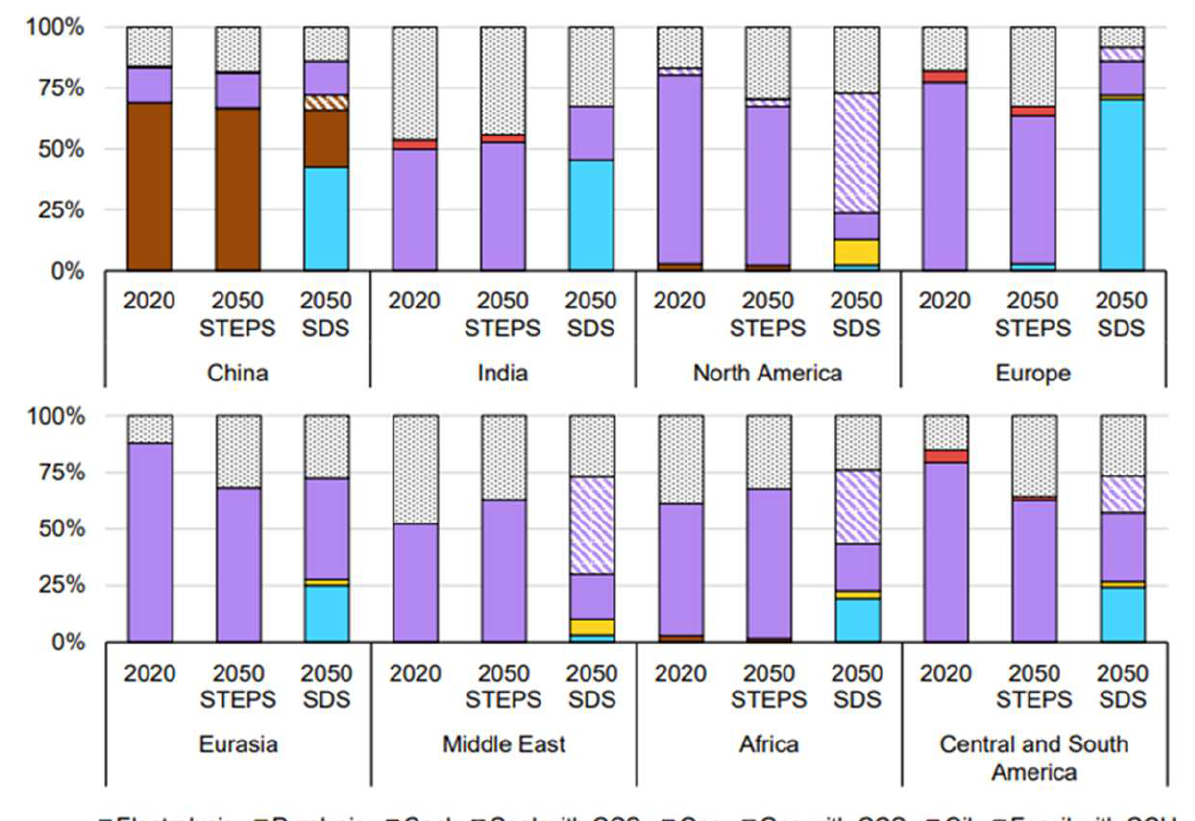
Figure 5. Various ammonia production pathways and scenarios in major ammonia-producing re- gions (STEPS: Stated Policies Scenario) [42] (Published under license CC BY 4.0).